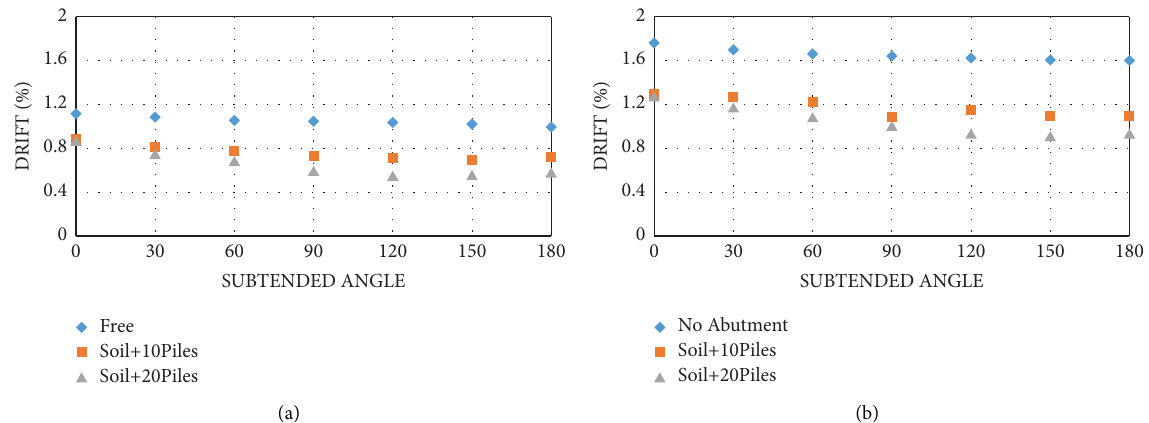
Figure 17: Real drift demands of the middle column in all bridge confgurations using GMs compatible to (a) DBE and (b) MCE response